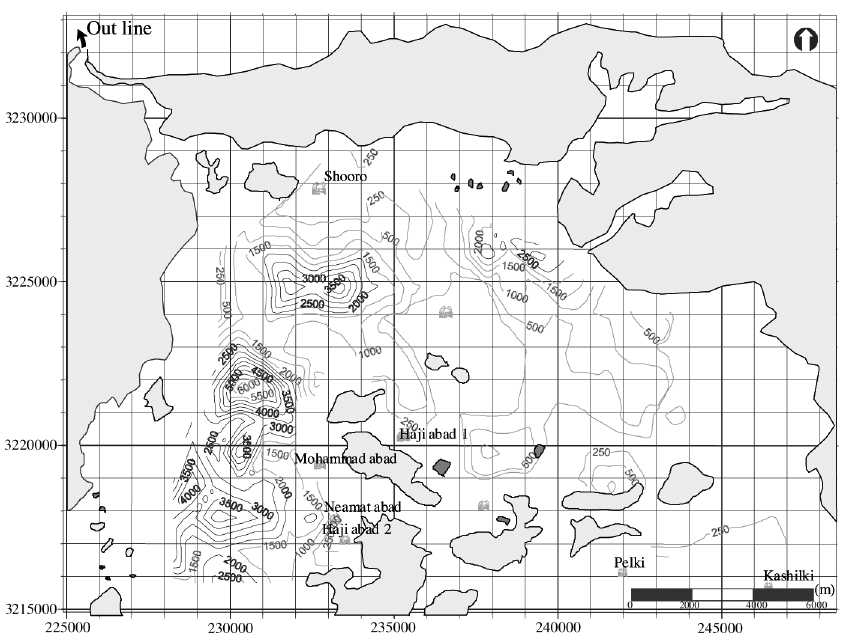
Fig. 6. RT map of the